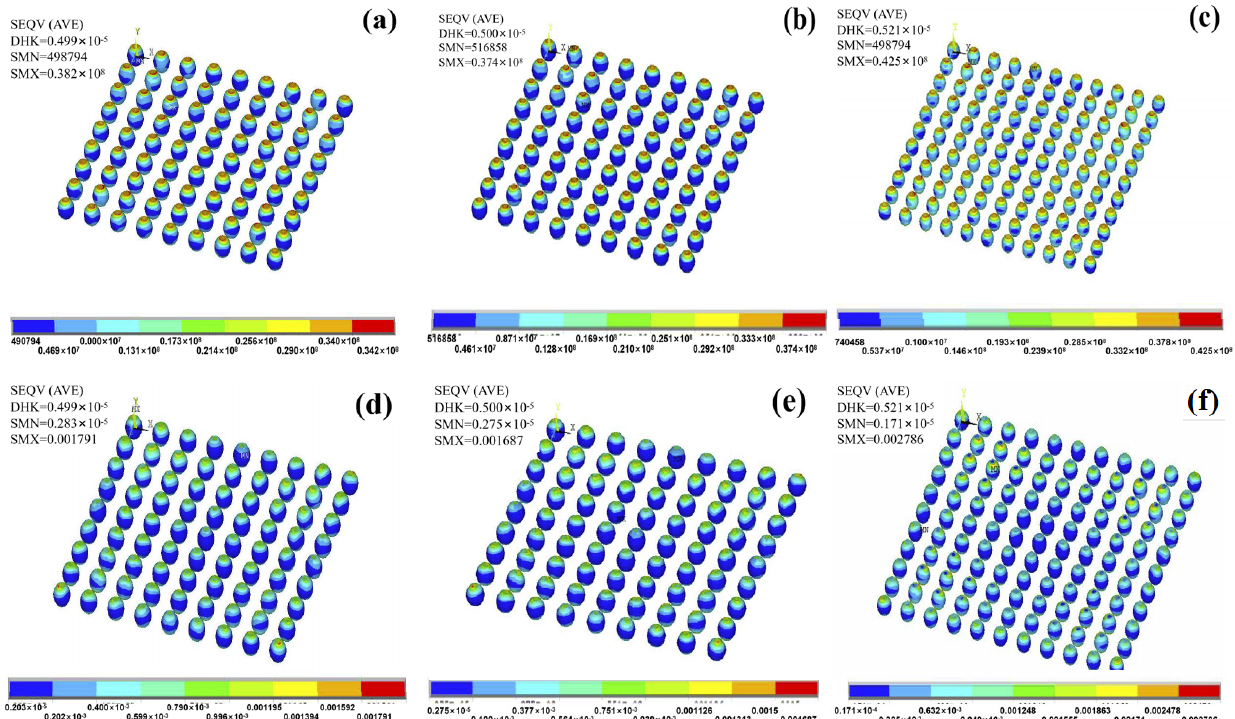
Figure 7. FEM analysis of stress ( a – c ) and strain ( d – f ) analysis of BGA80A electronic packaging subjected to TC: 9 × 9, SAC105: ( a , d ); 9 × 9, SAC105 ‐ (nano)Al 2 O 3 /Cu: ( b , e ); 11 × 11, SAC105 ‐ (nano)Al 2 O 3 /Cu: ( c , f ).